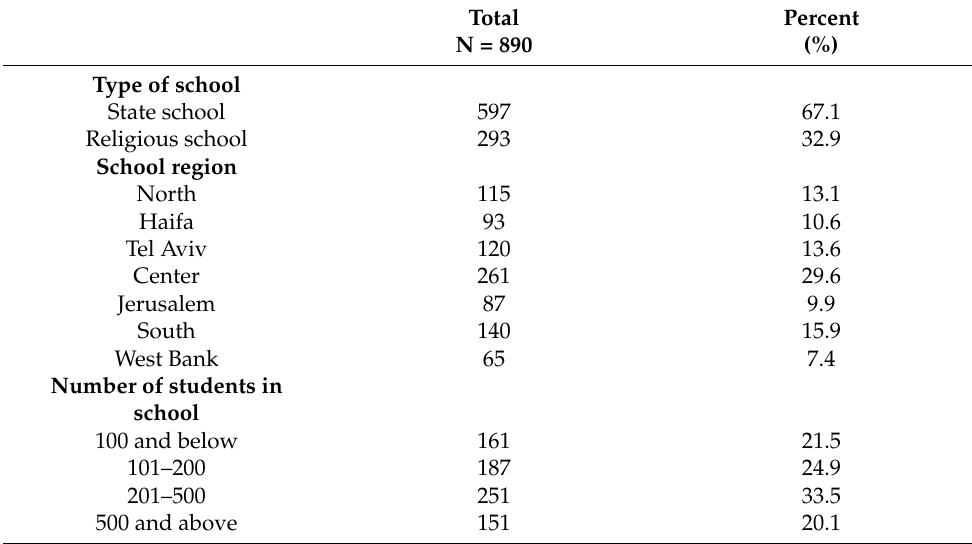
Table 2. Characteristics of schools sampled (N = 890).